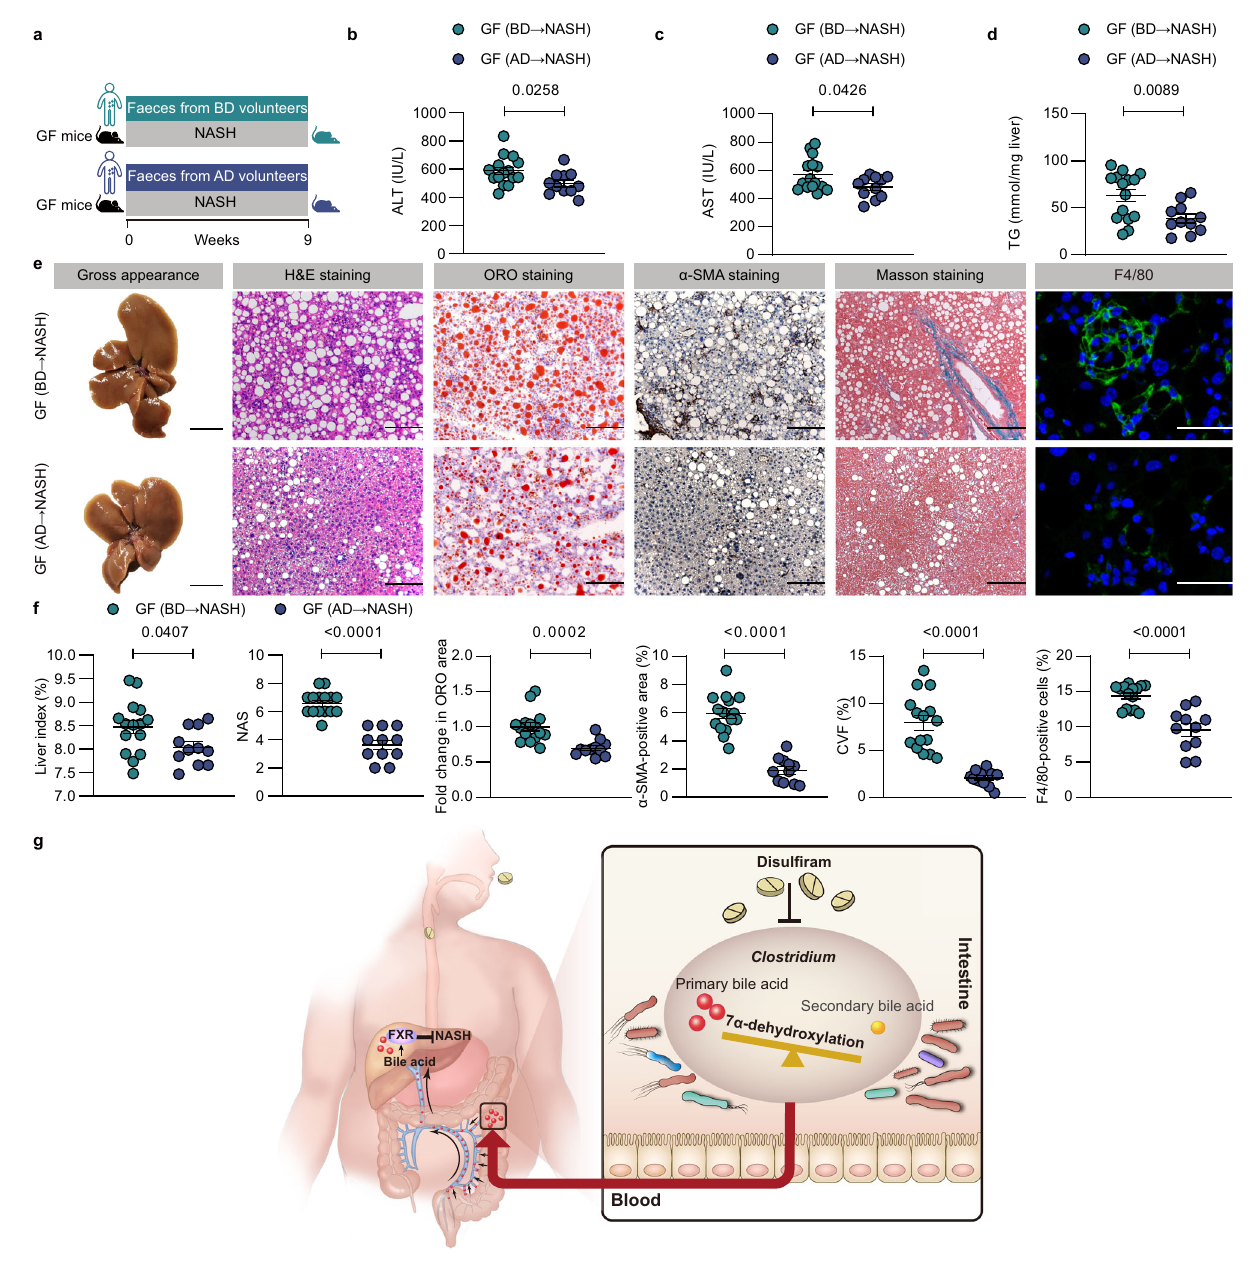
Fig. 7 | Transferring fecal microbiota obtained from DSF-treated humans into GF mice ameliorates NASH. a Experimental design. GF mice were fed a CDAHFD and randomized into 2 groups (GF (BD → NASH) and GF (AD → NASH)). Meanwhile, mice were gavaged with fecal contents obtained from BD and AD humans, respectively twice a week for 9 weeks. b – d Serum ALT and AST; hepatic TG. e Representative images of gross appearance of the liver histology (1cm) and photomicrographs of fi xed liver sections after staining with H&E (200 μ m), ORO (200 μ m), α -SMA antibody (200 μ m), Masson (200 μ m) and F4/80 antibody (50 μ m). f Quanti fi cation of the liver index (%), NAS, fold change in ORO area, α -SMA- positive area (%), CVF (%) and F4/80-positive cells (%). g Graphical abstract.